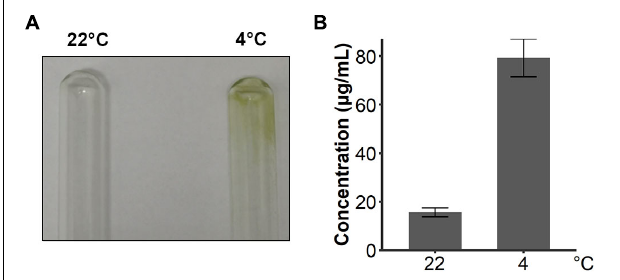
FIGURE 8 | C. nivalis secreted more EPS in cold environments. (A) Photograph of two tubes where the walls were adhered by cultures of C. nivalis growing at 22 ◦ C and 4 ◦ C separately. (B) Bar plot shows concentrations of EPS in C. nivalis growing at 22 ◦ C and 4 ◦ C for 3 days. Error bars represent the standard deviations of three biological